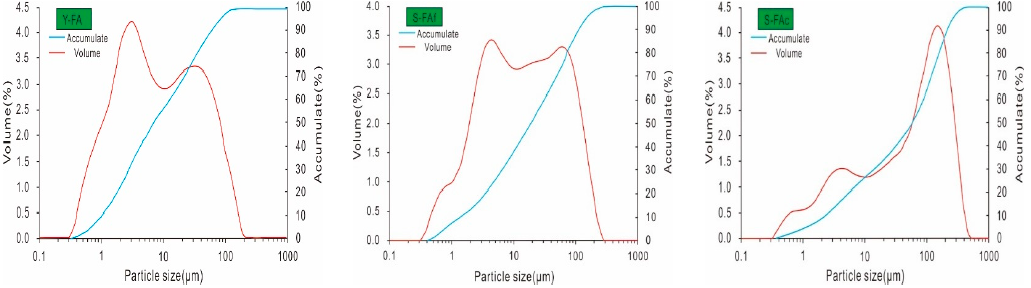
Figure 4. Particle-size distribution of Y-FA, S-FAf, and S-FAc. Y-FA, fly ash from Yihua power plant; S-FAf and S-FAc, fine fly ash and coarse fly ash from Shenhuo power plant.